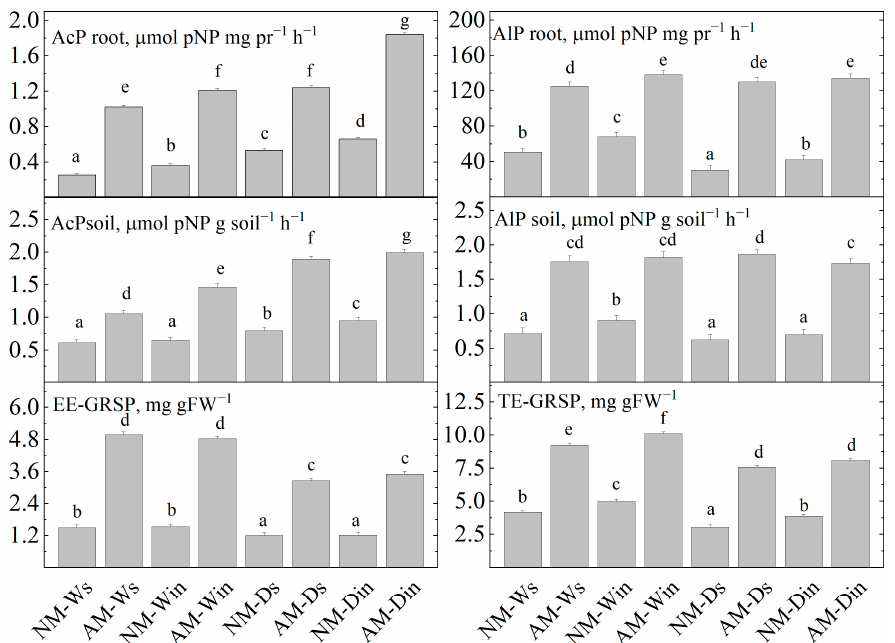
Figure 2. Activity of glomalin-related soil proteins, acid and alkaline phosphatases (AcP, AlP) in the roots and rhizosphere of P. peruviana : non-mycorrhizal ( NM ), AMF-inoculated (AM ), well-watered ( W ), drought-stressed ( D ), seed-propagated ( s ), and in vitro propagated ( in ) plants. Values are means ± SE, n = 5; common letters within a graph show no significant differences as determined by Fisher LSD test ( p ≤ 0.05) following ANOVA.